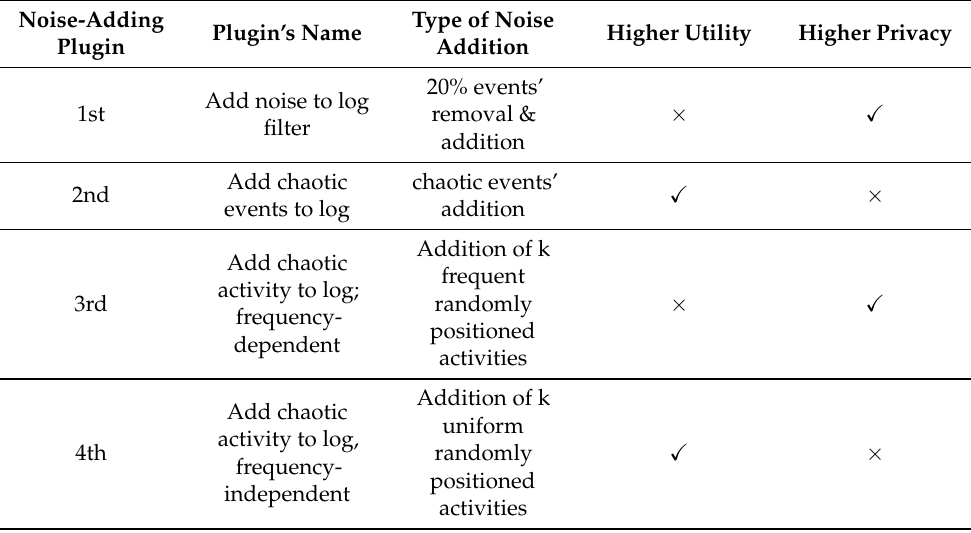
Table 4. 12 noise-adding plugins, their noise addition types, their and utility vis-a-vis privacy levels.